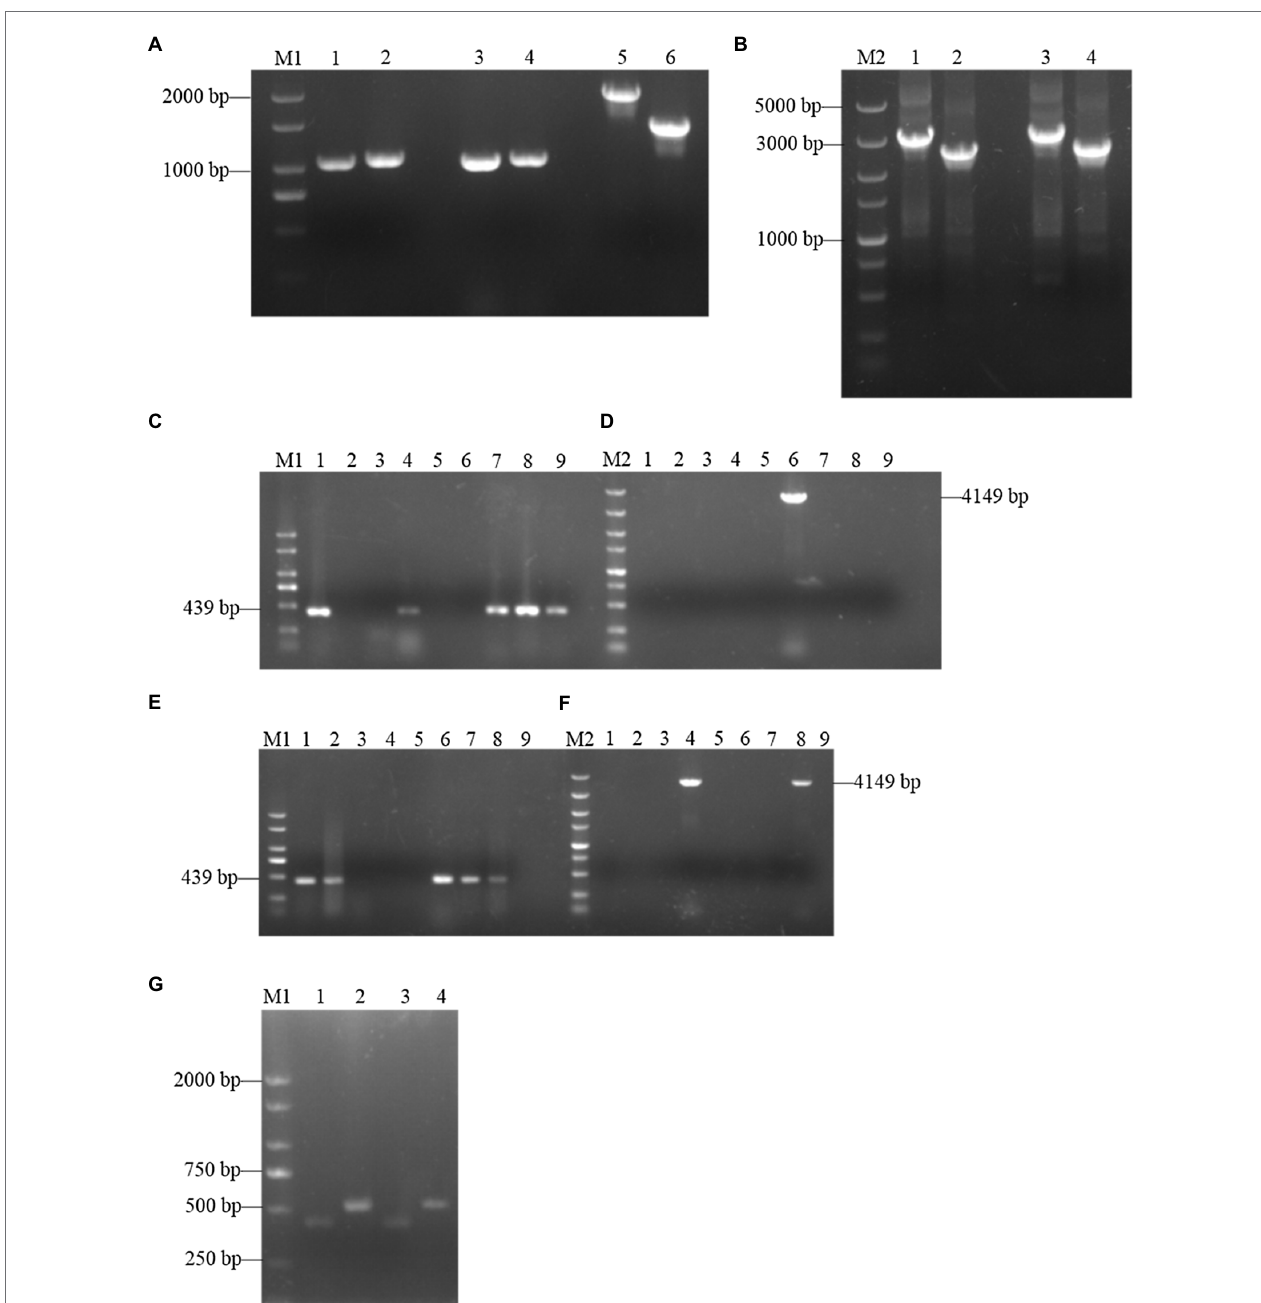
FIGURE 2 | Construction and validation of SsCI72380 gene knockout and complementary mutants. Lane M1 is the 2,000 marker, and lane M2 is the 5,000 marker. (A) PCR amplification. Lanes 1, 3 and 2, 4 represent the right and left borders of the wild-type Ss16 + and Ss16 − , respectively; lanes 5 and 6 represent the two overlapping HPT fragments with primer pairs Hpt-LB-F/226 and Hpt-RB-225/R, the band sizes of which were about 2 and 1.5 Kb, respectively. (B) Fusion- PCR. Lanes 1 and 3 represent the fusion fragments of the left borders of the wild-type Ss16 + and Ss16 − with the left HPT fragments, and lanes 2 and 4 represent the fusion fragments of the right borders of the wild-type Ss16 + and Ss16 − with the right HPT fragments, respectively. (C,D) The knockout mutant Δ Ss72380 + in the Ss16 + background was confirmed by PCR. In (C,D) , lanes 2–9 are transformants, lane 1 represents the wild-type. (C,D) denote that lane 6 was the deletion mutant as the internal primer pair SsCI72380 -JC-F/ SsCI72380 -JC-R was unable to produce a 439 bp band, while the external primer pair SsCI72380 -LB-F/Hpt-RB-R produced a 4,149 bp band corresponding to the inserted HPT gene from the deletion mutant. (E,F) The knockout mutant Δ Ss72380 − in the Ss16 − background was confirmed by PCR. In (E,F) , lanes 2–9 are transformants, lane 1 represents the wild-type. In the same way, (E,F) denote that lane 4 was the deletion mutant. (G) Electrophoretic validation of complementary mutants ( COM72380 + and COM72380 − ) positive transformants. Lanes 1 and 2 were verified by complementary mutant electrophoresis in Δ Ss72380 + background, lanes 3 and 4 were verified by complementary mutant electrophoresis in Δ Ss72380 − background, lanes 1 and 3 were the SsCI72380 target gene fragment, and lanes 2 and 4 were the target gene fragment of